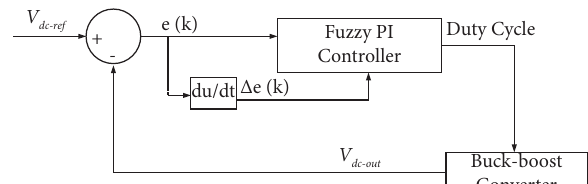
Figure 10: Control of the two-level buck-boost converter to the